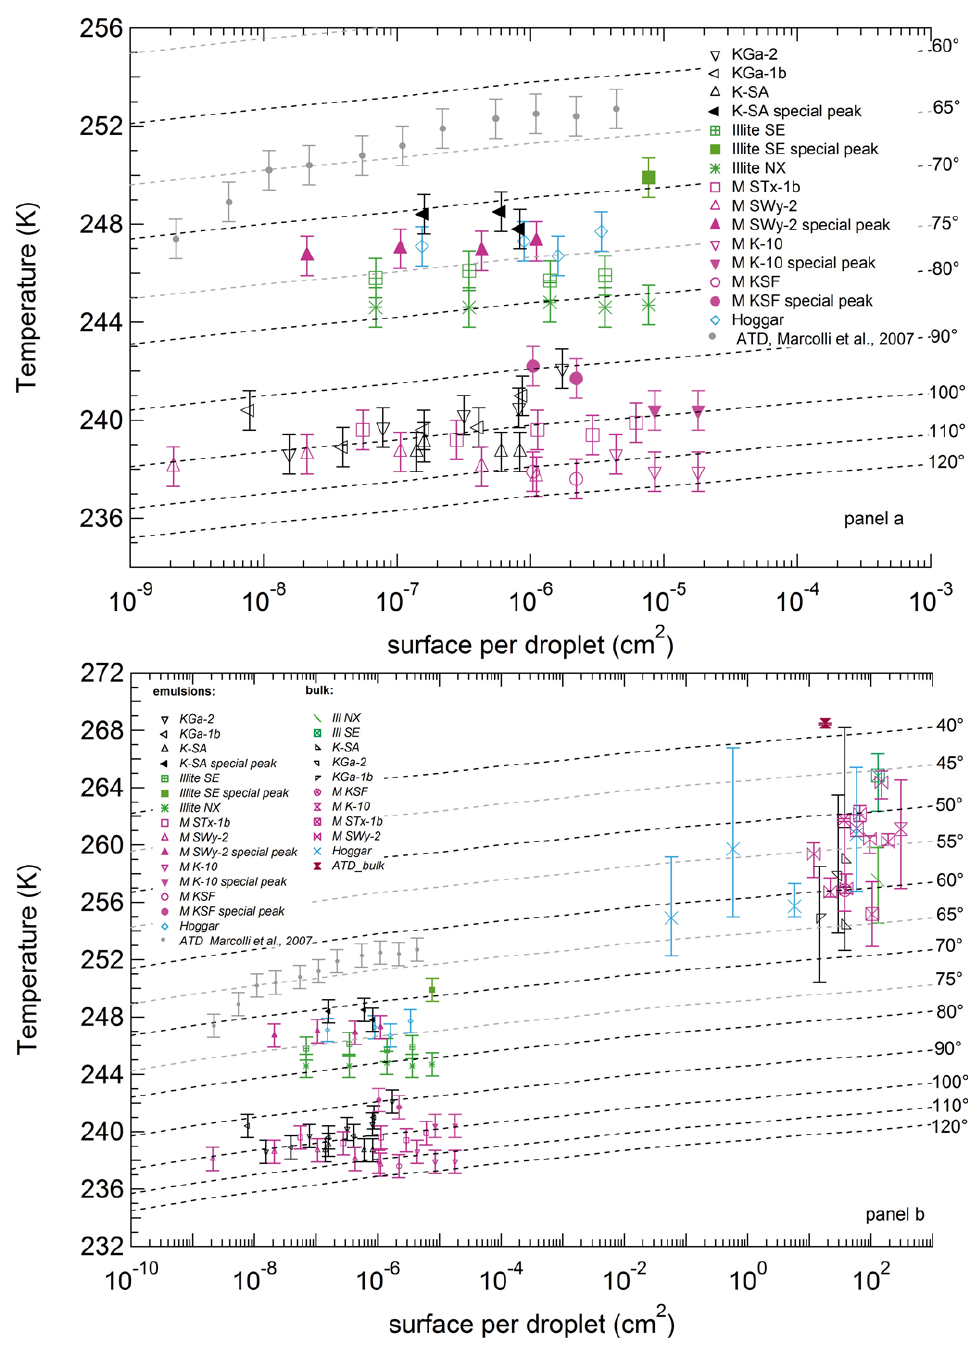
Fig. 11. Freezing temperatures as a function of the BET surface area per droplet. (a) Emulsion experiments. Different clay minerals are shown in different colours. Open and solid symbols represent standard and special peaks, T std on and T spcl on , respectively. Error bars indicate the uncertainties associated with the emulsion reproducibility. (b) Emulsion and bulk experiments. Symbols represent the average of median freezing temperatures for bulk experiments (see Table 2 for the 5wt% suspensions), T best vertical bars represent the spread in these tem- med peratures between freezing cycles. Grey dashed lines in both panels: calculated T on for a frozen droplet fraction of 0.01 (i.e. onset) using classical nucleation theory (CNT, parameterization of Zobrist et al., 2007) with the contact angle indicated on the right side. For emulsion experiments, the BET surface area per droplet was calculated by dividing the BET surface area present in an emulsion sample by the number of droplets present in an emulsion sample. The BET surface areas of Arizona Test Dust experiments from Marcolli et al. (2007) (grey dots) were calculated with values taken from Teipel et al.